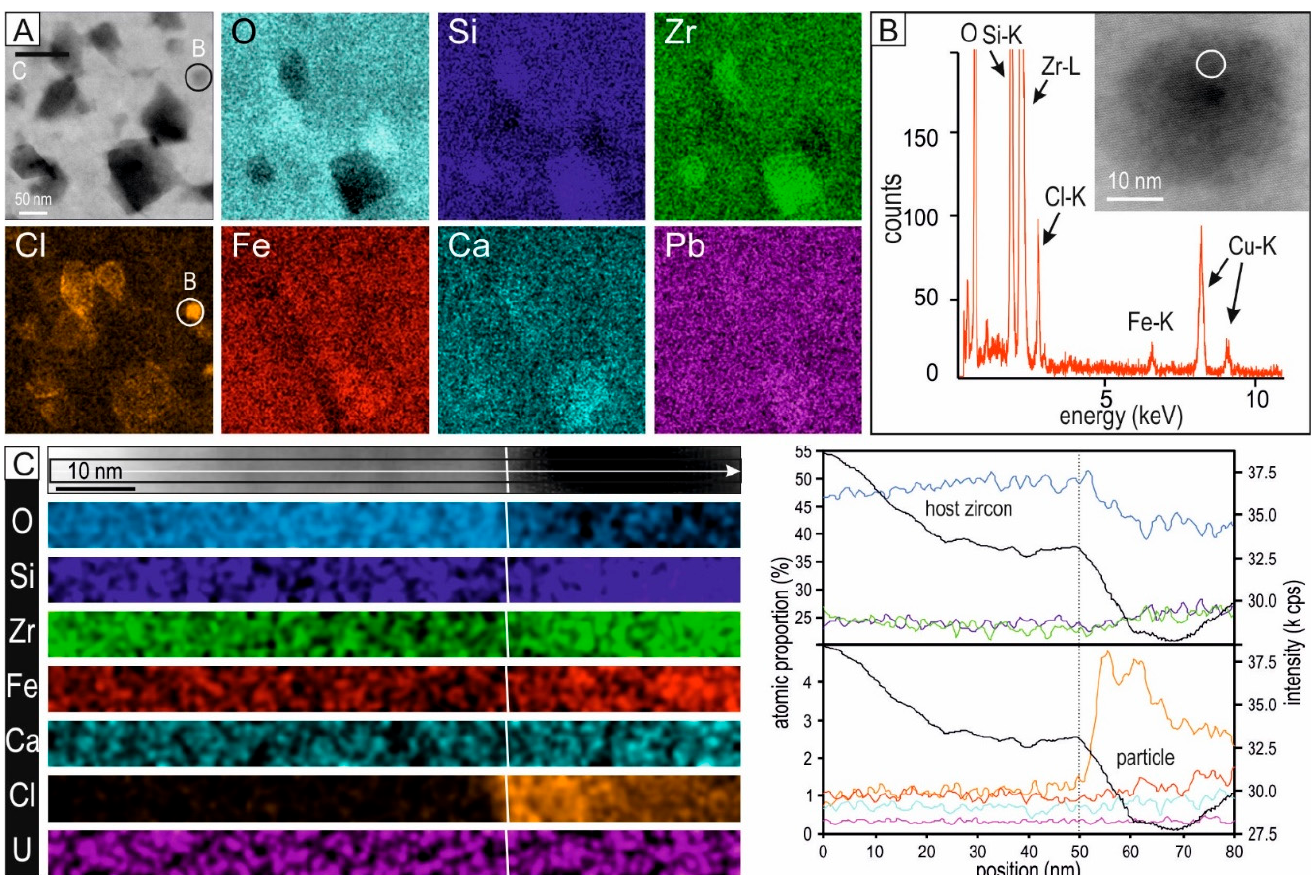
Figure 10. Aspects of nanoscale inclusions + pores throughout the mottled bands in the OD distal zircon (Foil #1). ( A ) Image and EDS STEM maps for a Cl-rich area selected from Figure 8C showing that the highest Cl was recorded in the smallest particles with no differences on the major or trace elements maps. Inverse correlation between O and Zr was recorded for the coarser, darkest inclusions with moderate enrichment in Cl. Note the weak variation in Fe and Ca, but not in Pb. ( B ) EDS spectrum for Cl-richest nanoparticle circled in ( A ). ( C ) EDS STEM maps (left) and profiles (right) across a particle with medium Cl-enrichment in ( A ). Profiles show high concentrations of Cl at the particle margin with increases in both major and minor elements but a strong HAADF signal decrease.